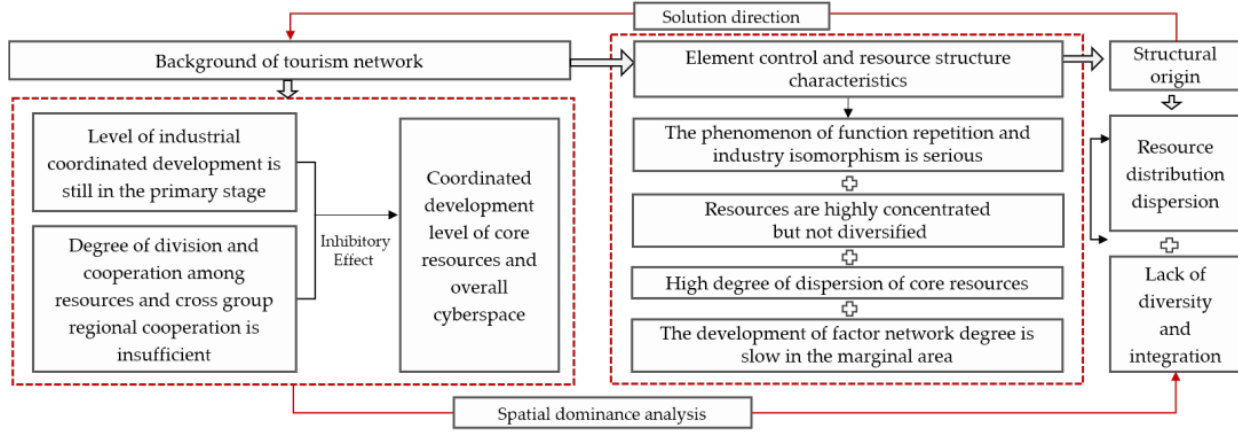
( b ) Figure 13. Transformation of the network structure and organization mode: ( a ) overall dispersion with a partial concen- tration and ( b ) overall concentration with a partial dispersion.